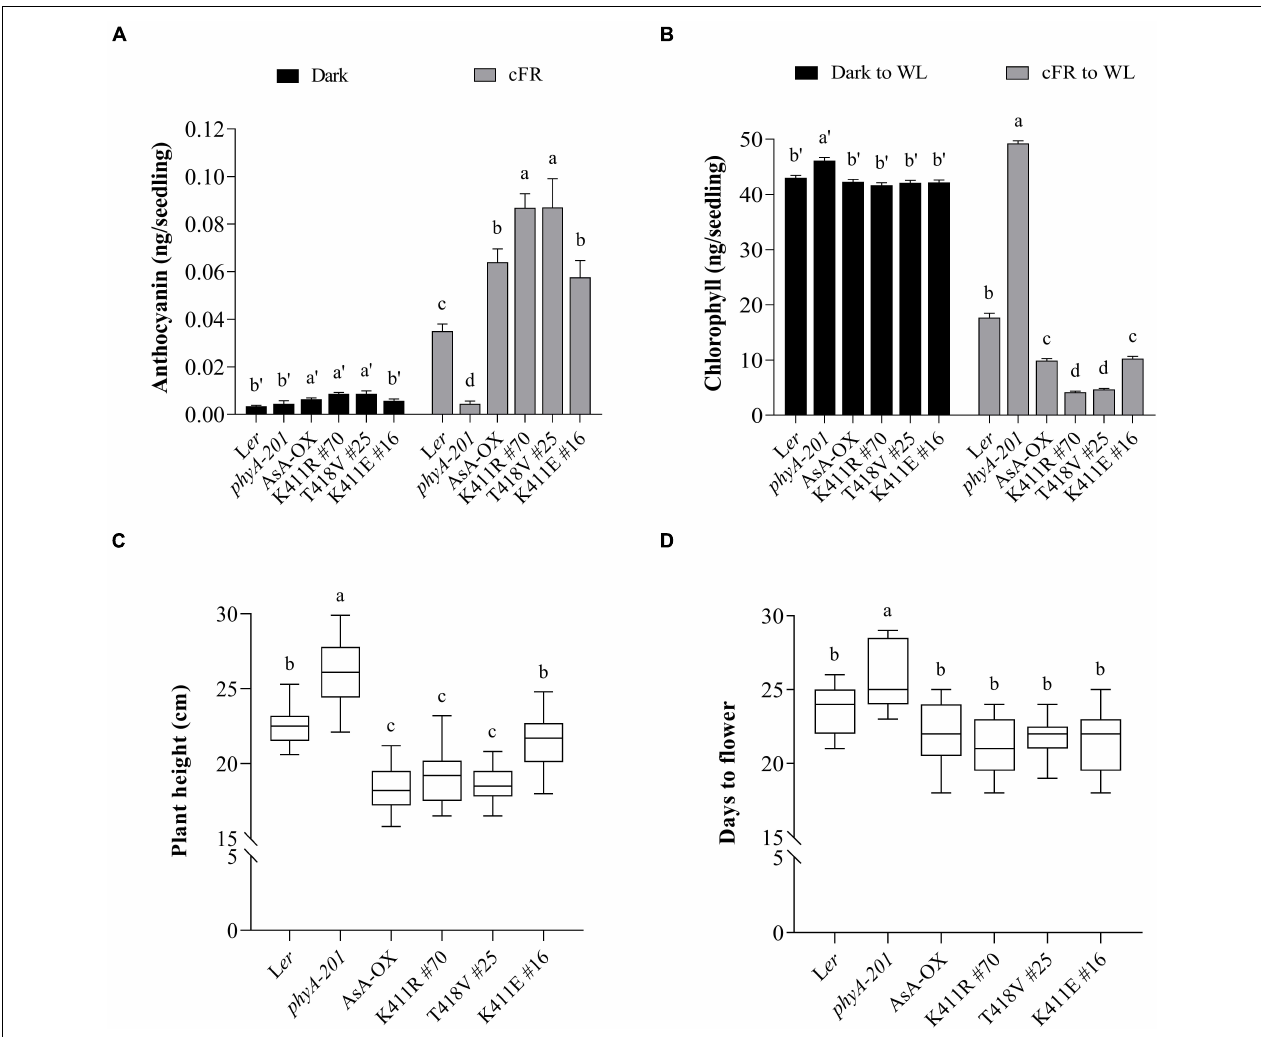
FIGURE 3 | Pigment and phenotypic analysis of transgenic plants with AsphyA kinase mutants. (A) Anthocyanin content analysis. Fifty seedlings grown for 4 days in the dark or under cFR (5 µ mol · m − 2 · s − 1 ) were used for the extraction of samples. Data represent means ± SD from three independent measurements. (B) Chlorophyll content analysis. Fifty seedlings grown for 3 days in the dark or under cFR (5 µ mol · m − 2 · s − 1 ) were transferred to white light (WL, 150 µ mol · m − 2 · s − 1 ) and grown further for 1 days before analysis. Data represent means ± SD from three independent measurements. (C,D) Phenotypic analysis. Plant height (C) was measured from 4-week-grown plants, and flowering time (D) was measured from the days at bolting, with plants grown under long day condition (16 h light/8 h dark photoperiod). Data represent means ± SD ( n ≥ 30). Means with different letters are significantly different at P < 0.01, using Duncan’s multiple range